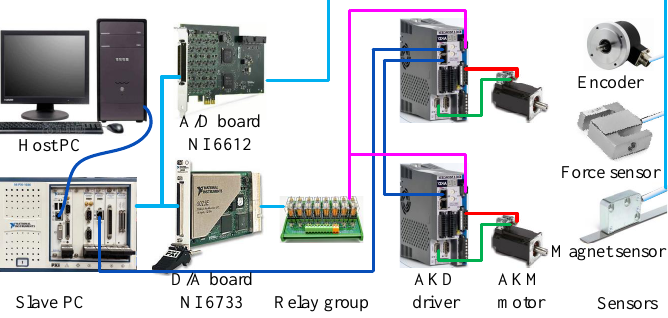
Figure 5. Framework of the control system.